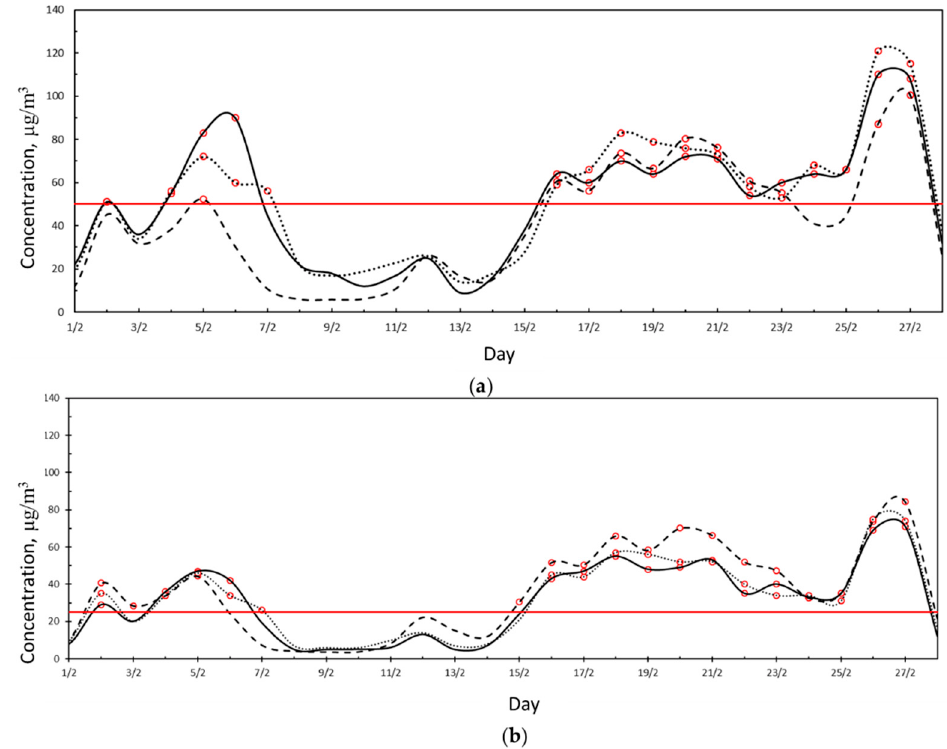
Figure 5. ( a ) PM10 daily average concentration measured at the SA station (solid black line), VC station (dotted black line), and MV station (dashed black line). Red line represents the legal limit concentration according to D.Lgs. 155/2010. Red dots represent exceedance with respect to the legal limit. ( b ) PM2.5 daily average concentration measured at the SA station (solid black line), VC station (dotted black line), and MV station (dashed black line). Red line represents the legal limit concentration according to D.Lgs. 155/2010. Red dots represent exceedance of the legal limit.